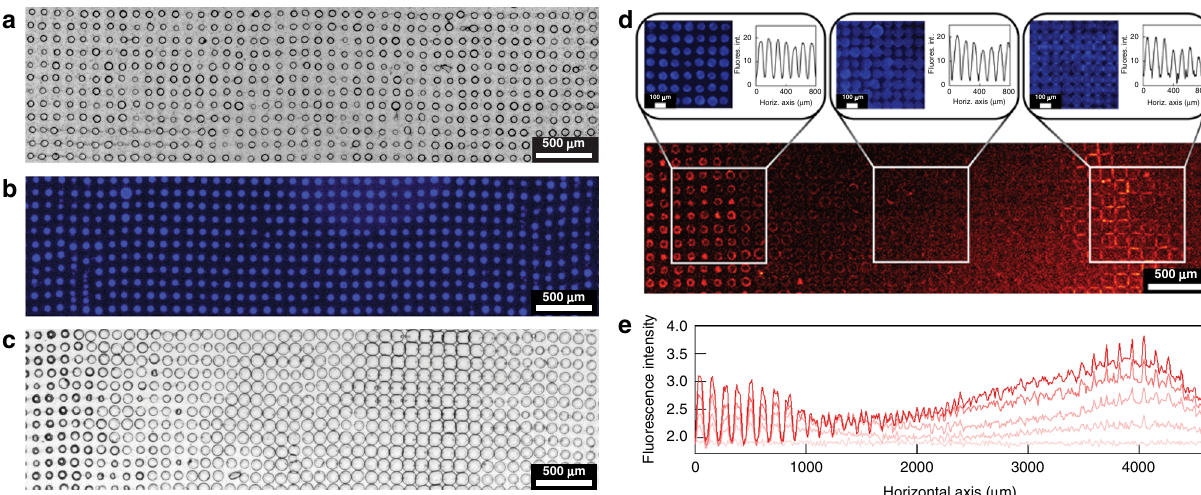
Fig. 3 Parallel catalytic processing in synzyme protocells. a Bright fi eld microscopy image showing an acoustically trapped 2D array of immobilized HRP- containing PDDA/ATP coacervate microdroplets. The fi eld of view is 5.0 × 1.5 mm. b Corresponding fl uorescence microscopy image showing the homogenous distribution of sequestered Dylight405-labeled HRP (blue fl uorescence) within individual coacervate droplets throughout the acoustically patterned array. c Bright fi eld microscopy image showing recon fi guration of a uniform population of HRP-containing coacervate droplets into a spatially separated trimodal community after exposure to a unidirectional PTA/Ru 4 POM chemical gradient. The PTA/Ru 4 POM mixture (7.5 µ L, PTA: Ru 4 POM = 7:1 mol/mol; [PTA] = 17.6 mM; [Ru 4 POM] = 2.4 mM; pH 6.5) was injected to the left of the image at a distance of 15 mm from the observation window (5.0 × 1.5 mm). Distinct zones of non-contact small-sized Ru 4 PCVs (left side), medium-sized Ru 4 PCVs with membrane-membrane contacts (center), and highly expanded Ru 4 PCVs showing compression-induced deformation (center right) are observed (see Supplementary Movie 2). d Fluorescence microscopy images of an array of HRP-containing Ru 4 PCVs 16 min after homogeneous addition of H 2 O 2 and Amplex Red ( fi nal concentrations 40 and 10 μ M, respectively). The bottom image shows zones (left and right sides) of red fl uorescence arising from protocells operating with a dominant HRP- mediated pathway giving rise to a resoru fi n output. The central region shows only background levels of red fl uorescence due to prevailing synzyme activity and competitive decomposition of H 2 O 2 to O 2 and water . A homogenous distribution of coacervate-sequestered Dylight405-labeled HRP (blue fl uorescence) is observed throughout the array (top images). Selected regions are delineated by the white squares and top images show blue fl uorescence images and corresponding fl uorescence intensity line pro fi les. e Time-dependent averaged resoru fi n fl uorescence line intensity pro fi les recorded across the array shown in d . Increasing color saturation indicates increased elapsed time. Time intervals = 0, 4, 8, 12, and 16